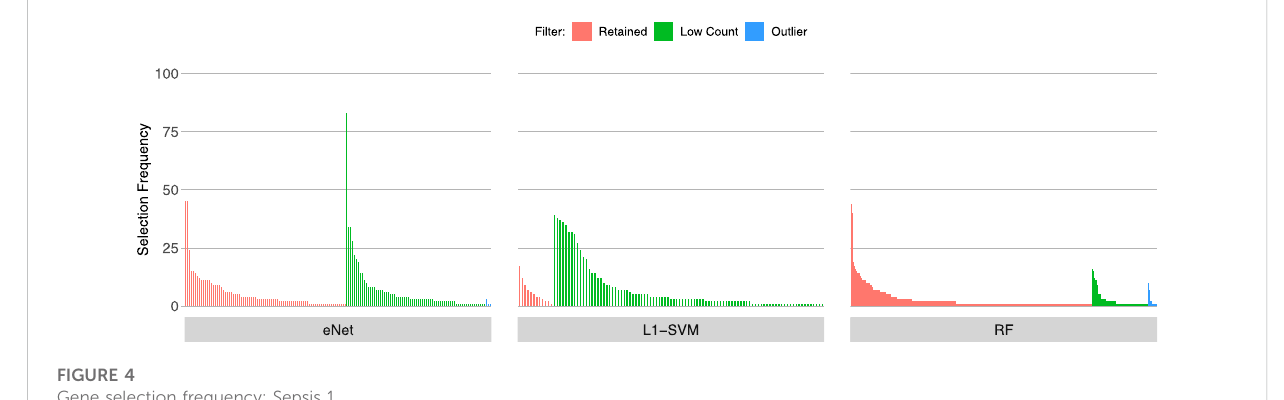
FIGURE 4 Gene selection frequency: Sepsis 1.